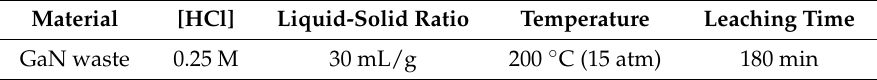
Figure 11. The flowchart of the best leaching method. Table 4. The optimal parameters of the leaching process.